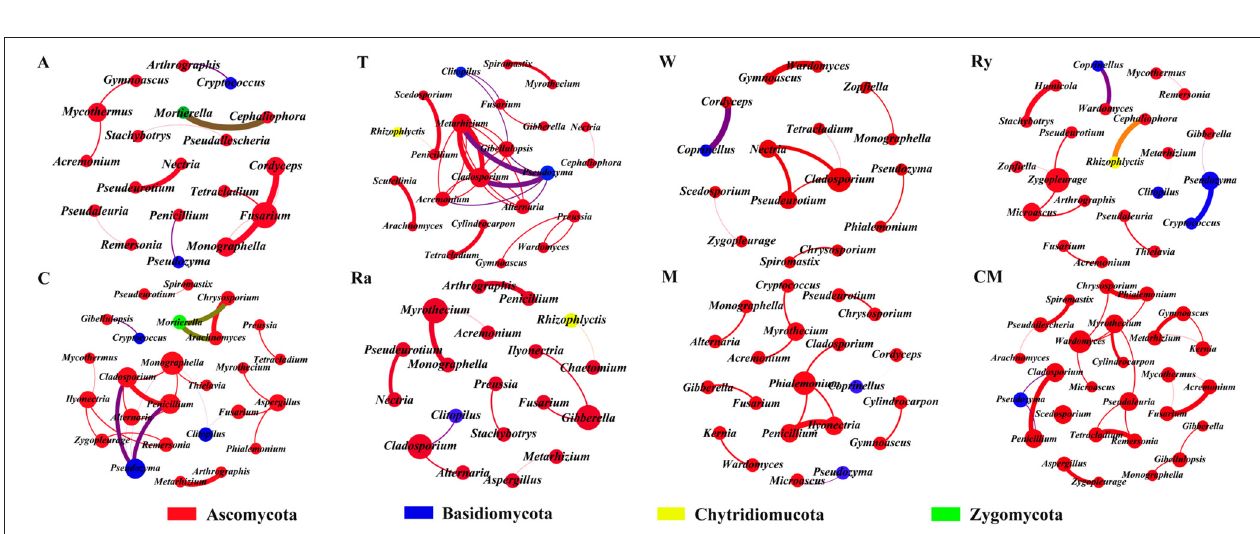
FIGURE 7 | Network of co-occurring fungal genera based on correlations analysis for intercropping cultivations and cucumber monoculture. A connection stands for a strong (Spearman’s ρ > 0.6) and significant ( P < 0.01) correlation. The size of each node is proportional to the degree, the thickness of each edge is proportional to the value of Spearman’s correlation coefficients. Nodes colored by